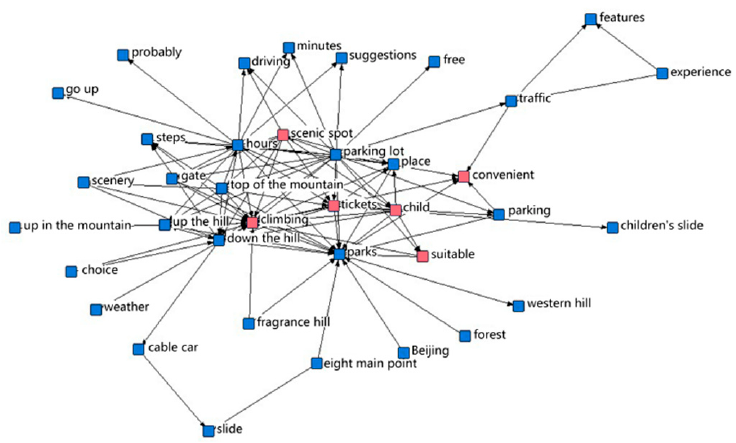
Figure 14. The semantic network of females’ evaluations.